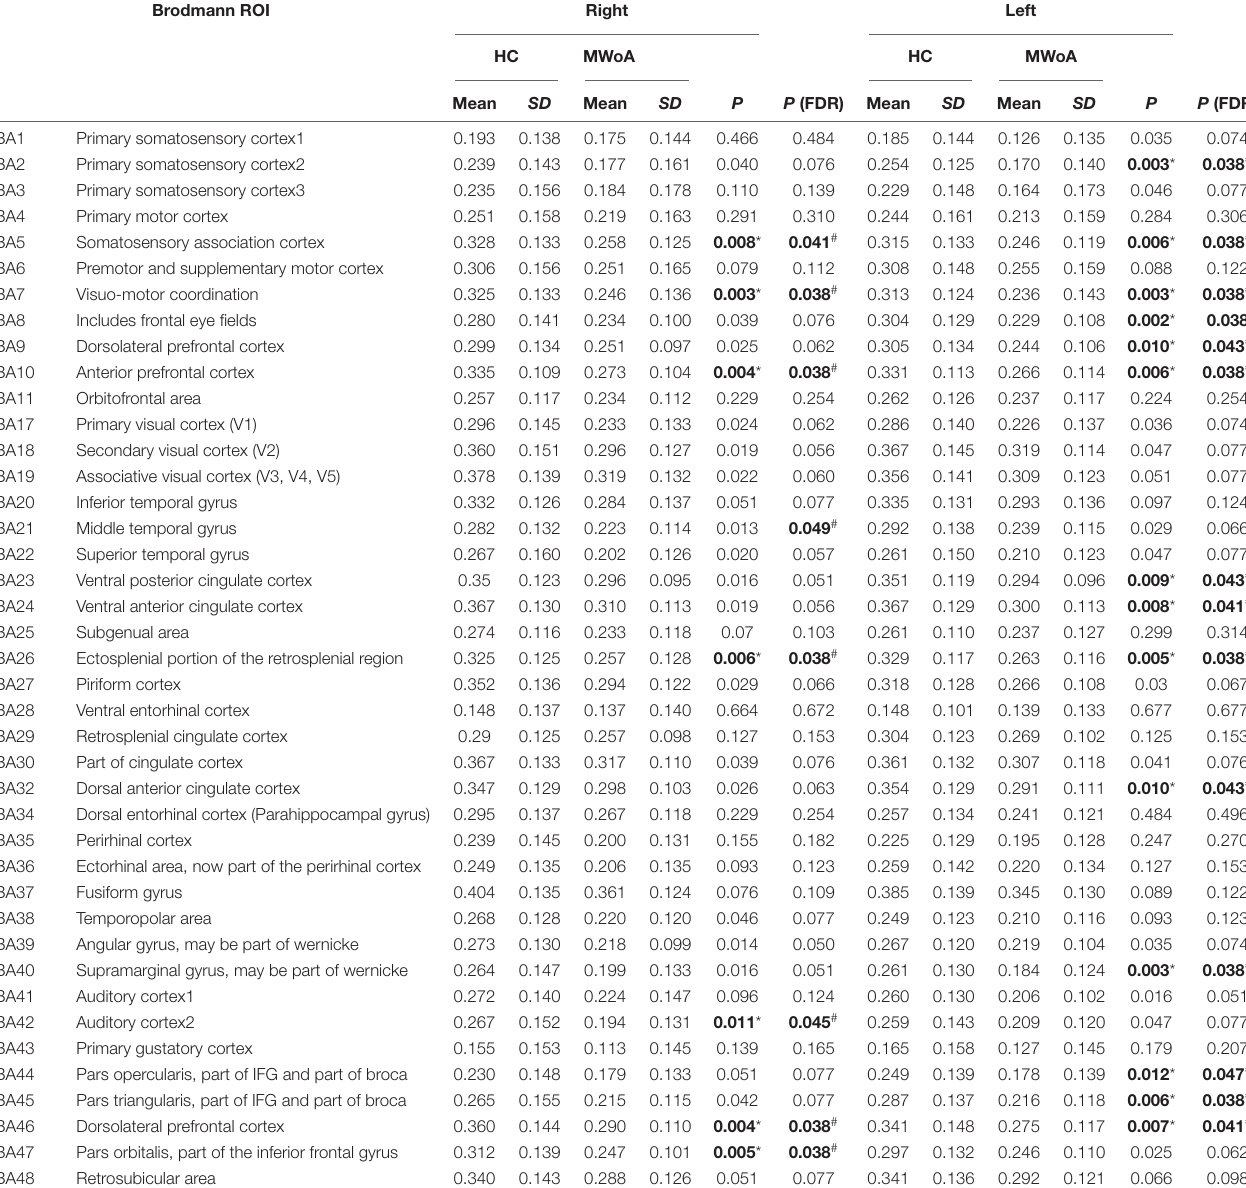
The P-values are based on two-tailed t-tests of Z scores of the correlation coefficients. The results were assigned thresholds at p < 0.05 (FDR adjusted). The asterisks (*) denote p < N/1. The ( # ) denote p (FDR adjusted) < 0.05. The bold values represented significant results after indicated FDR correction or p < 1/N correction.